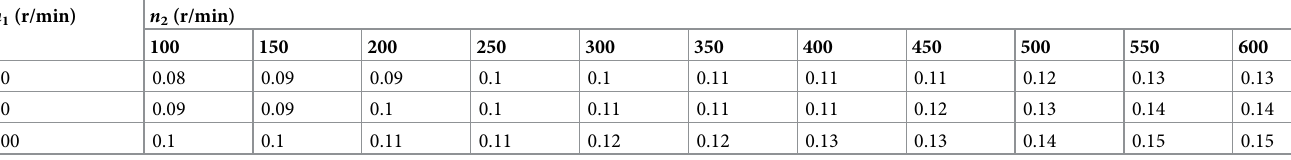
Table 5. Sand power consumption of scheme 1-3(kW � h).